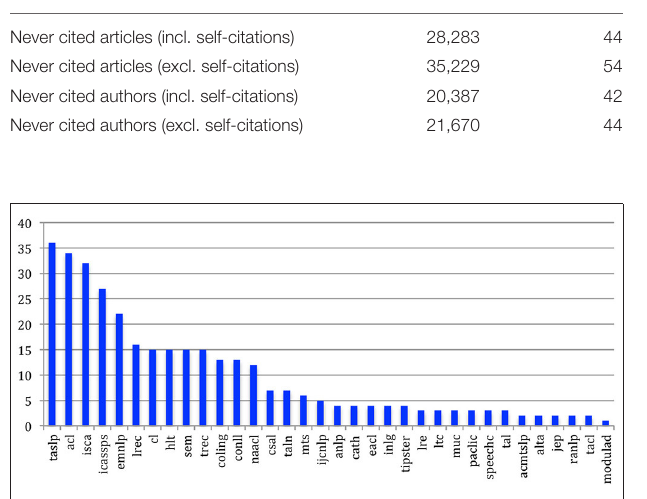
FIGURE 55 | Internal h-index of the 34 sources.